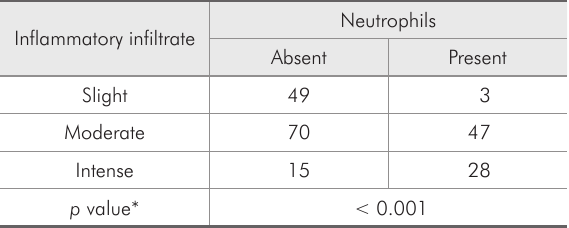
Table 2 - Intensity of inflammatory infiltrate according to presence of neutrophils in periapical cysts.